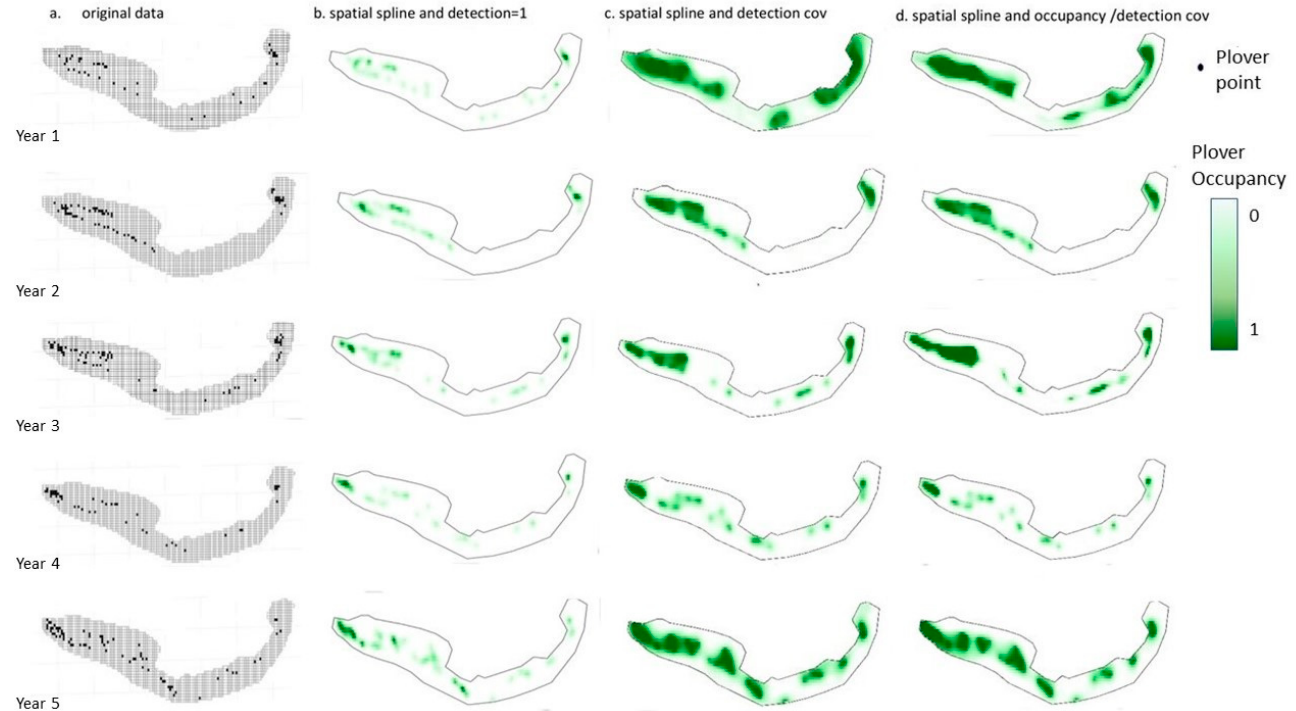
Land 2023 , 12 , x FOR PEER REVIEW 9 of 15 Figure 2. Piping plover occupancy with the spatial spline maps of hotspot distribution areas, showing areas with perfect detection (1), areas with detection covariates, and occupancy/detection covariates. For visual comparison, the original data are provided. Values range from 0 (white) to 1 (dark green).